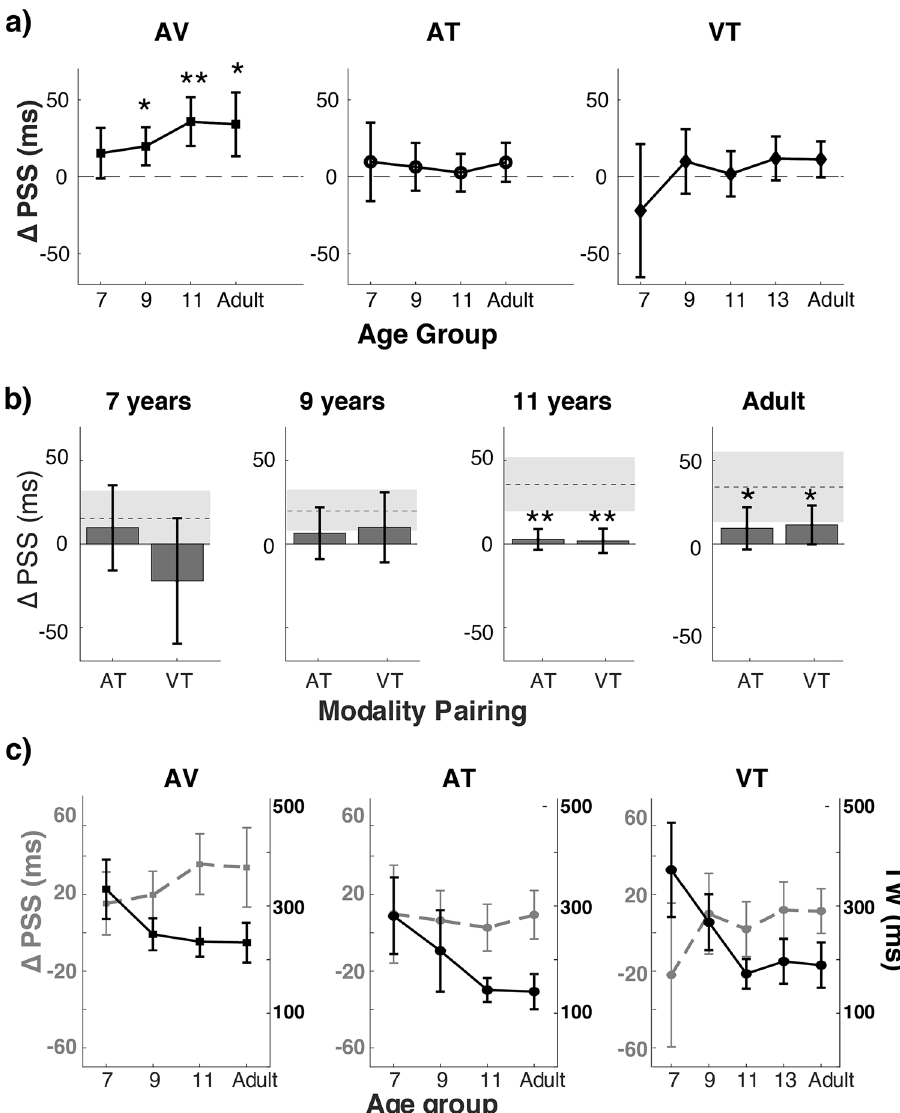
Figure 2. Effect of age on rapid temporal recalibration and the width of the simultaneity window ( a ) The developmental trajectories of PSS shifts (representing the size of rapid recalibration) are plotted for audio–visual (AV; left panel), audio–tactile (AT; middle panel), and visual–tactile (VT; right panel) pairings. Compared to a hypothesized PSS shift of 0 ms, PSS shifts for audio–visual pairings were statistically significant at 9 years and older ages. In contrast, none of the age groups showed a significant shift for the audio–tactile and visual–tactile pairings. ( b ) PSS shifts were larger for audio–visual pairings than for the other two cross-modal pairings by 11 years of age and in adults. Dashed lines represent the average PSS shifts for audio–visual pairing and the grey shaded areas represent 95% confidence intervals. ( c ) The developmental trajectories of the width of the simultaneity window. Compared to the trends in PSS shifts (superimposed, grey dashed lines), the width of temporal window decreased with age for all cross-modal pairings. All error bars represent 95% confidence intervals. Asterisks represent significance on at least one of the statistical tests (i.e., one-sample t-tests or bootstrap hypothesis tests; *smallest p < .05, **smallest p <